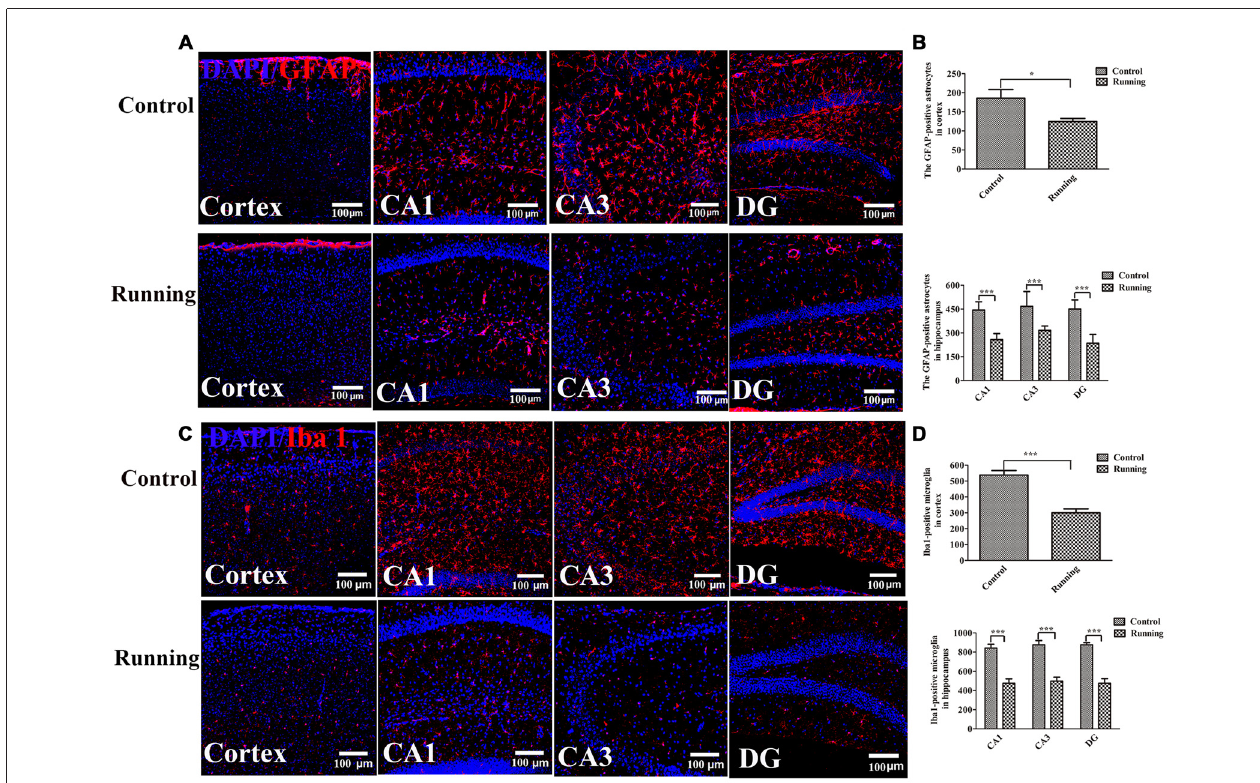
FIGURE 5 | Effects of voluntarily running on the activation of astrocytes and microglia. (A) Immunofluorescent staining of glial fibrillary acidic protein (GFAP)-positive astrocytes in the control and running groups (200 × , scale bar = 100 µ m). (B) Histogram comparing the numbers of GFAP-positive astrocytes in the cortex and hippocampus ( n = 6 per group). (C) Immunofluorescent staining of ionized calcium-binding adapter molecule 1 (IBA1)-positive microglia in the control and running groups (200 × , scale bar = 100 µ m). (D) Histogram comparing the numbers of IBA1-positive microglia in the cortex and hippocampus ( n = 6 per group). Datasets are expressed as means ± SD, n = 6. ∗ P ≤ 0.05; ∗∗∗ P ≤